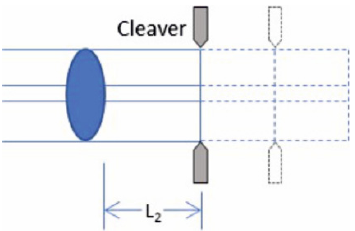
Figure 3. Schematic of the procedure for adjusting L 2 .